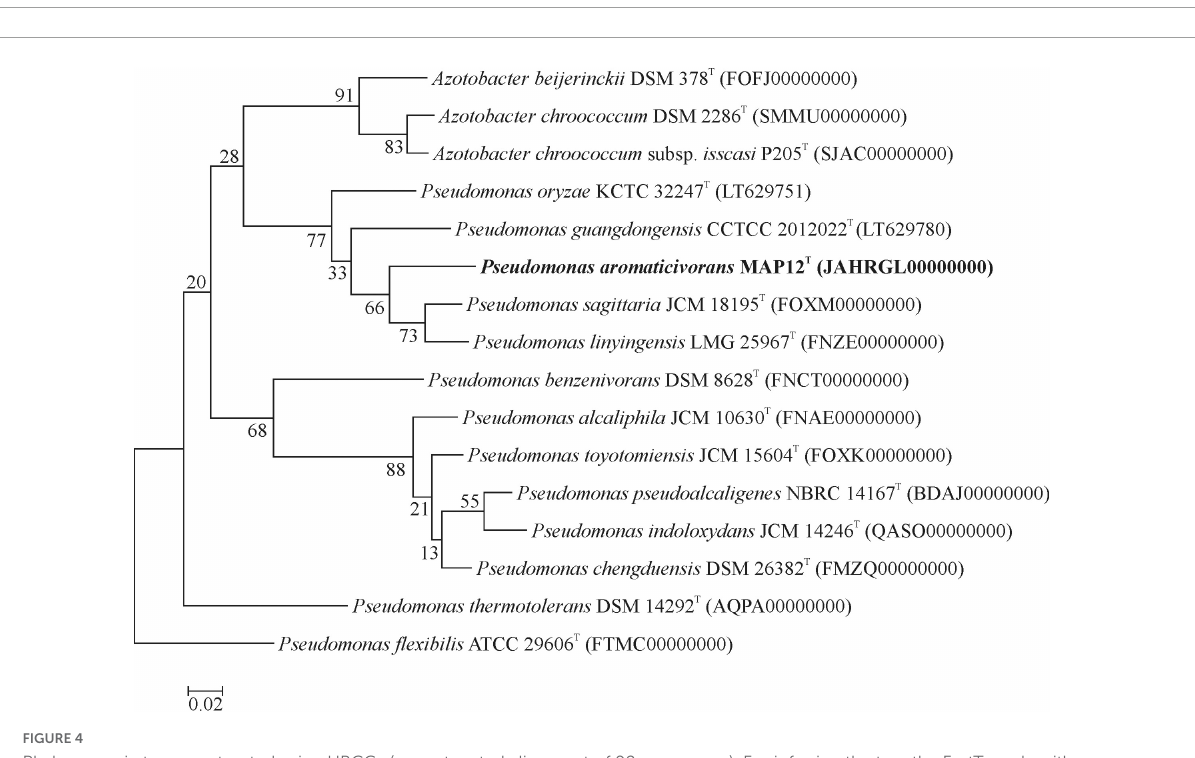
FIGURE4 Phylogenomic tree constructed using UBCGs (concatenated alignment of 92 core genes). For inferring the tree the FastTree algorithm was used. Bar, 0.05 substitution per nucleotide